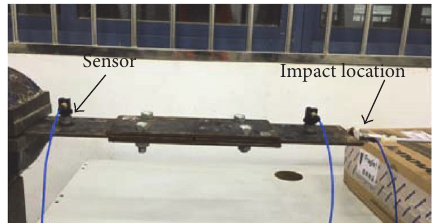
Figure 17: Double shear lap beam experimental setup.